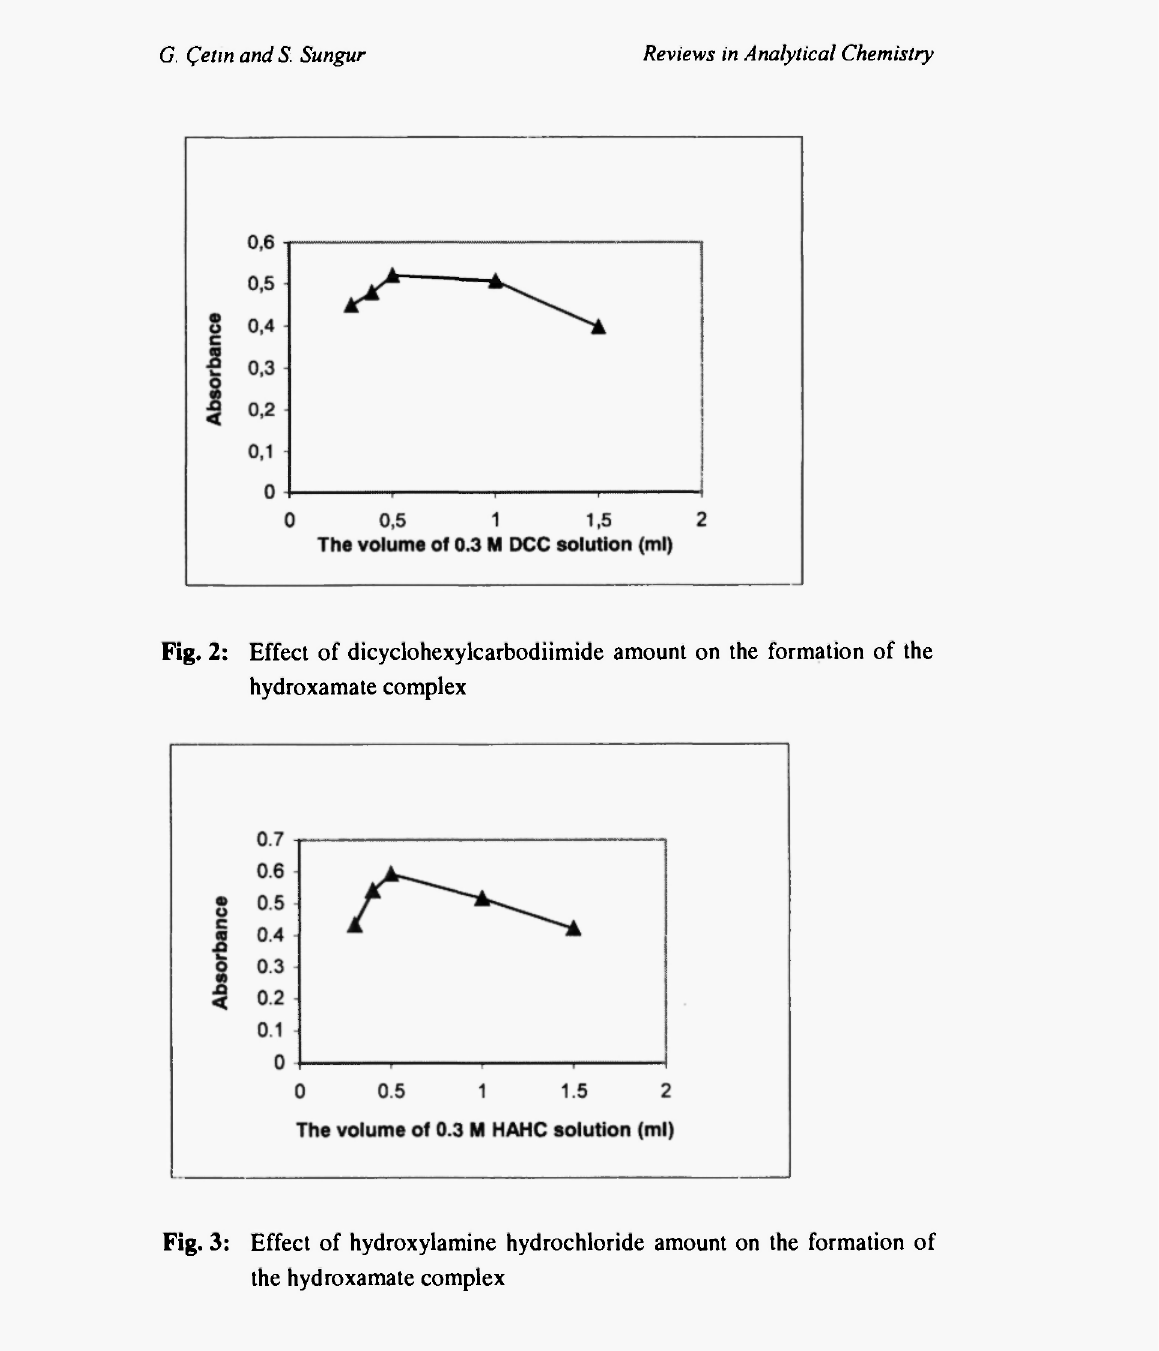
Fig. 3: Effect of hydroxylamine hydrochloride amount on the formation of the hydroxamate complex